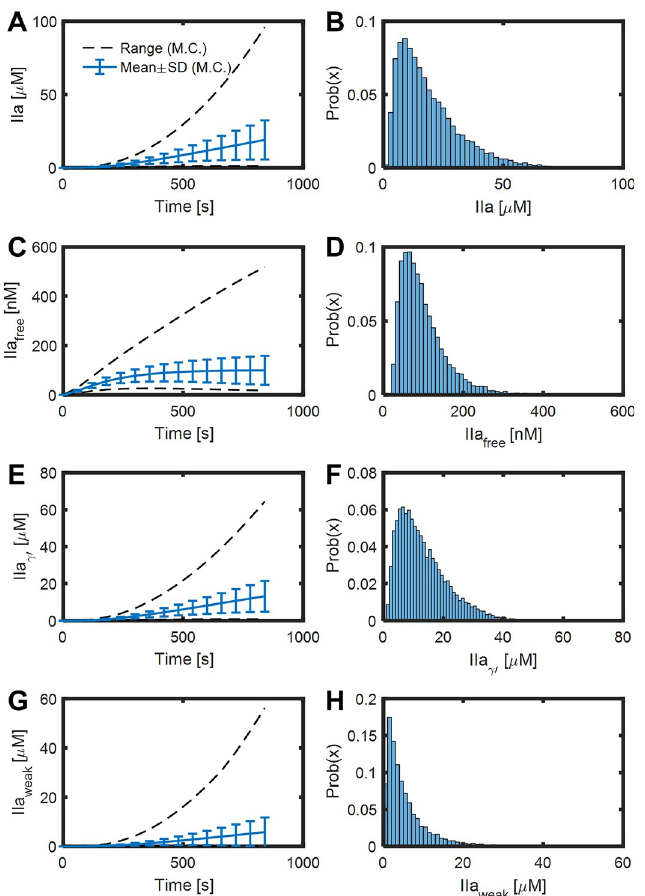
Fig 5. Total, free, and bound thrombin of 10,000 simulations of blood clotting over collagen/ TF under venous flow rate. The mean, standard deviation, range (A, C, E, G) and the distribution at 800 sec (B, D, F, H) of thrombin on different sites of 10000 MC simulation varying plasma protein levels and thrombin binding sites ± 50% uniformly and independently.